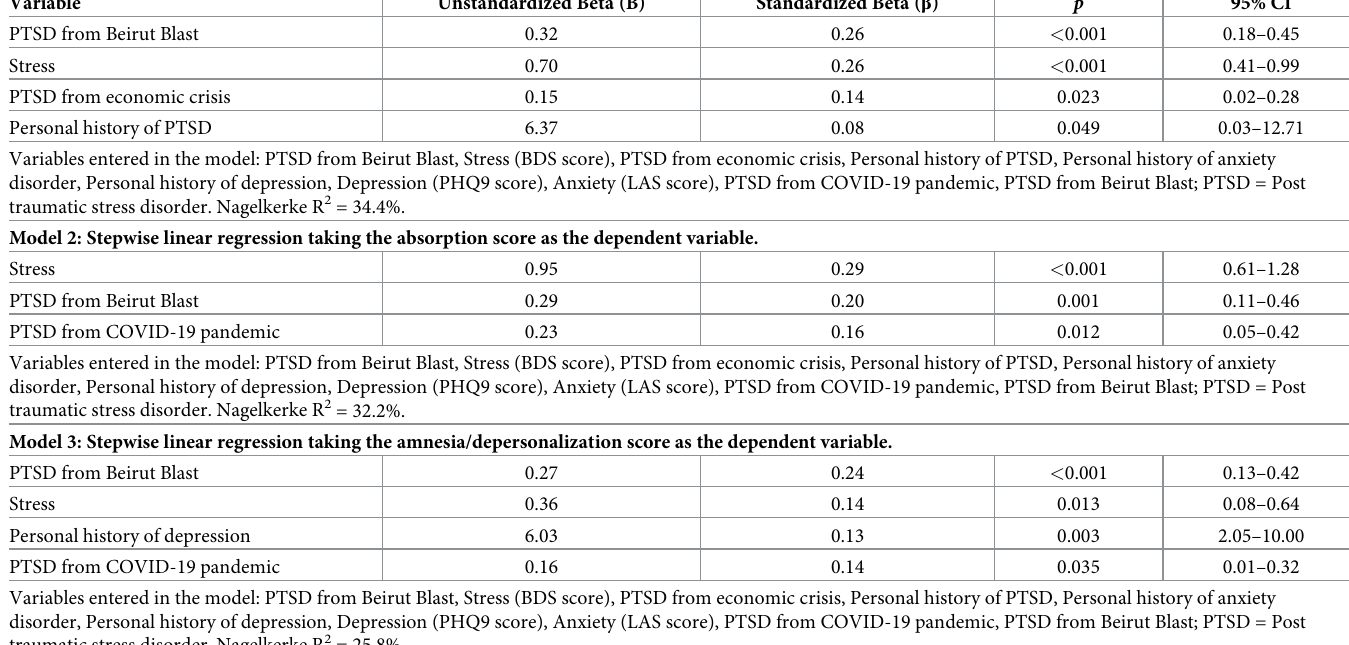
traumatic stress disorder. Nagelkerke R 2 =